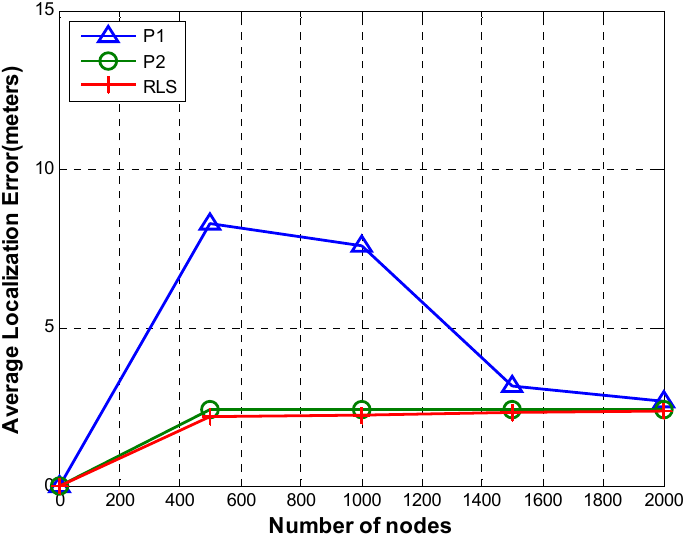
Figure 17. Localization error (sparsity).